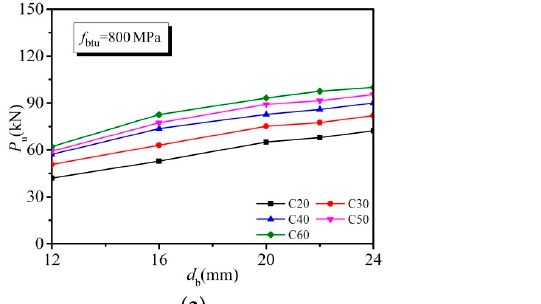
Figure 11. Effect of bolt diameter: ( a ) shear bearing capacity; ( b ) load–slip relationship.